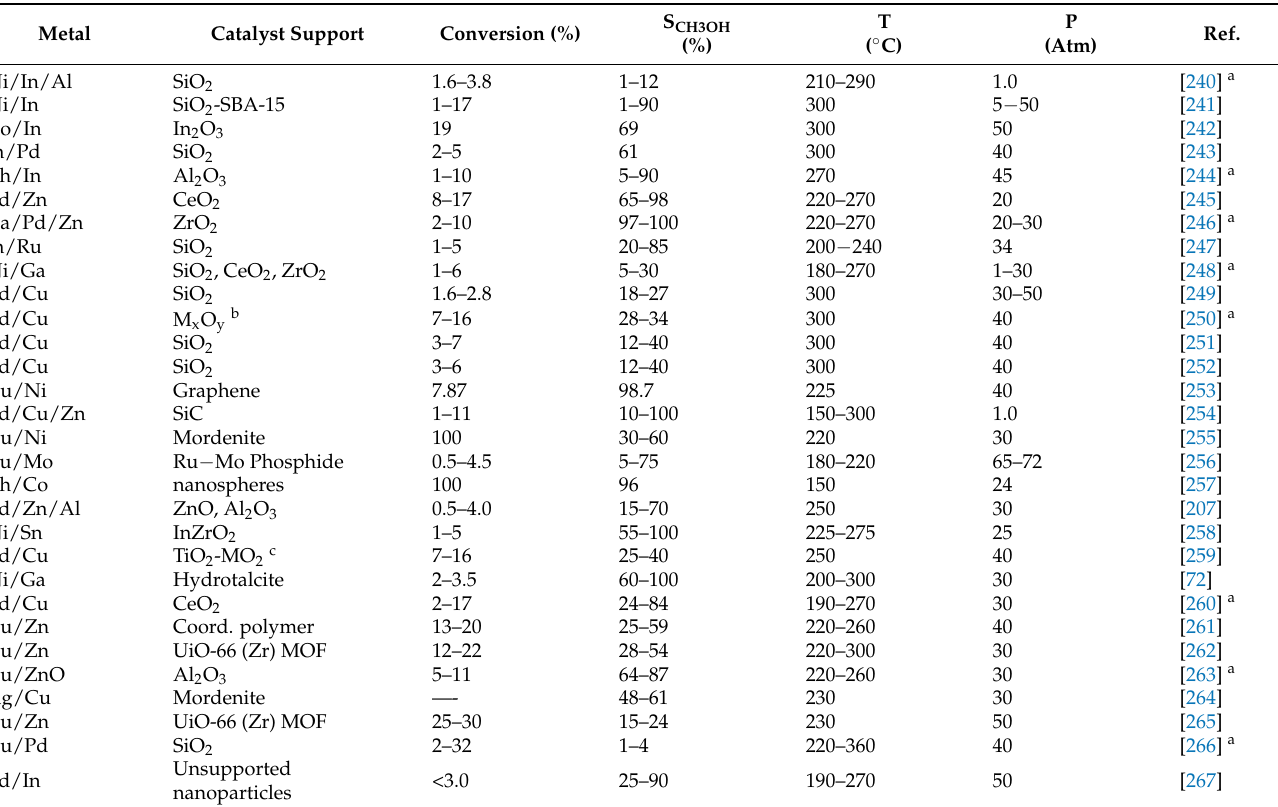
Table 7. A comparative summary of different bimetallic-supported catalysts studied in the carbon dioxide hydrogenation process to obtain